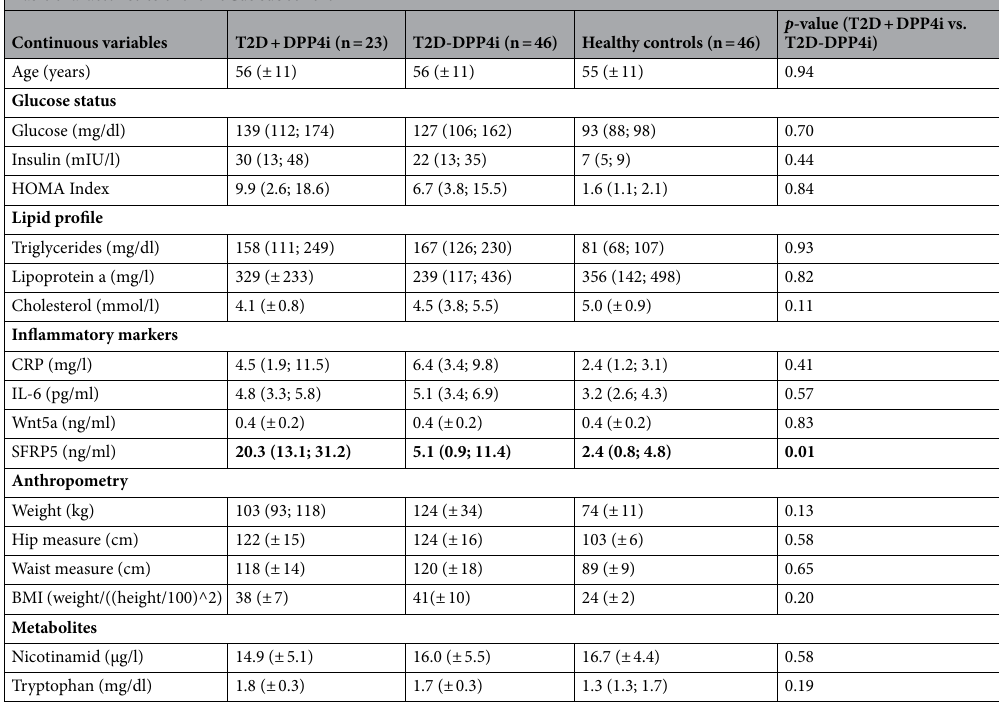
Table 1. Basic characteristics of the FoCus subcohort stratified into subjects taking DPP4i (T2D + DPP4i), without DPP4i treatment (T2D-DPP4i) and healthy controls. Values of normal distribution are shown as mean (standard deviation), values of non-normal distribution are shown as median (25th; 75th percentile); Subjects were matched by age and gender. Wilcoxon Test; statistical significance: p < 0.05. Significant values are in